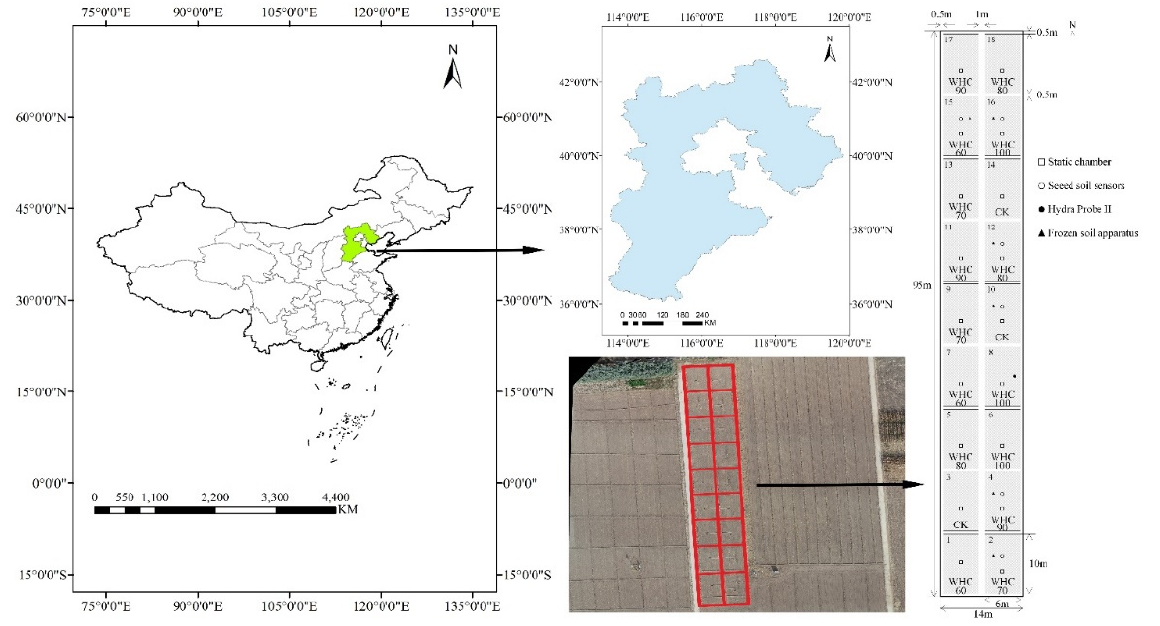
Figure 1. Geographic location of the study area and plots arrangements .